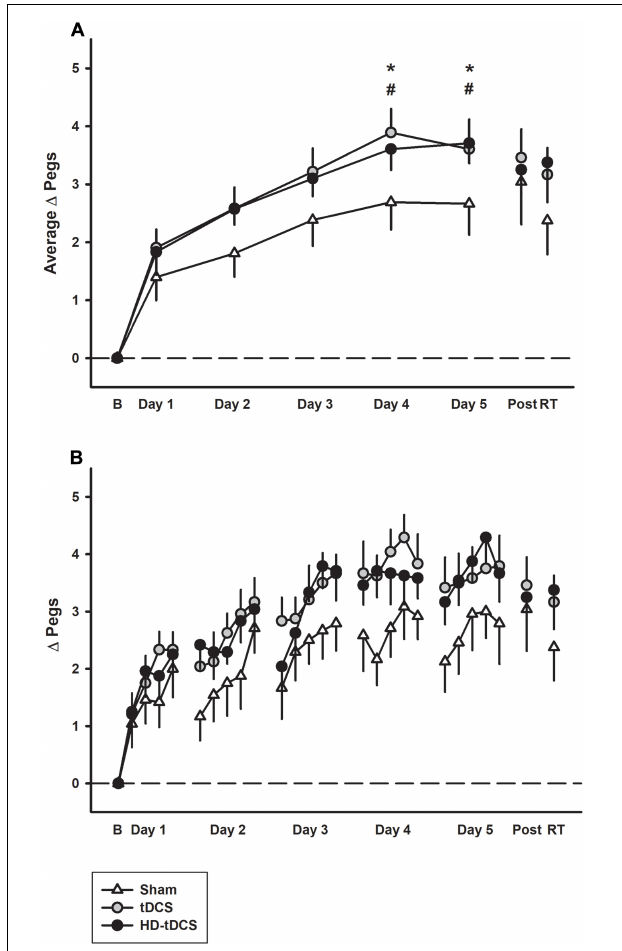
FIGURE 2 | Motor learning by treatment group. (A) The mean daily change from baseline (B) in left Purdue Pegboard (PPT L ) learning curves for sham (white triangles) were lower than both tDCS (gray circles) and HD-tDCS (black circles). Effects decayed by 6 weeks retention time (RT) for sham but not tDCS groups. (B) Daily mean scores per repetition of the PPT L are shown for the same three groups. ∗ p < 0.05 for tDCS vs. sham, # p < 0.05 for HD-tDCS vs. sham.